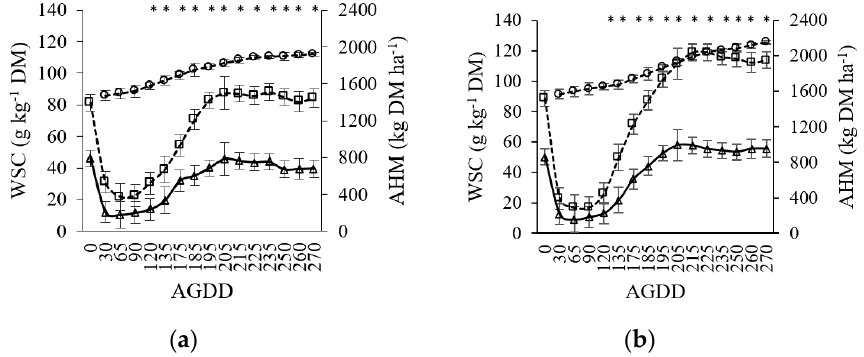
Figure 5. Mean water soluble carbohydrates (WSCs, g kg − 1 DM) and accumulated herbage mass (AHM, kg DM ha − 1 ) in Bromus valdivianus Phil. ( a ) and Lolium perenne L. ( b ) in: leaf blade (- △ -) and leaf sheath (-- □ --) defoliated at 270 accumulated growing degree days (AGDDs) and AHM (--o--). * Indicates significant differences ( p < 0.05) between leaf sheaths and blades for the same species. Bars indicate the standard error.